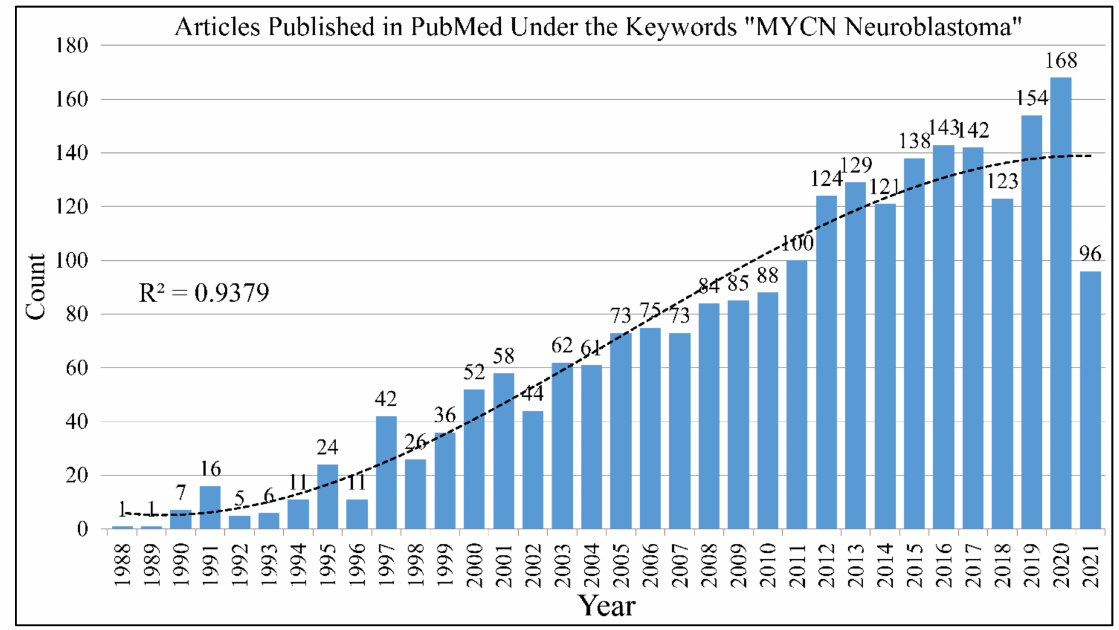
Figure 1. The literature concerning the role of MYCN in neuroblastoma. A total of 2166 citations come up in the PubMed database with the keywords “MYCN” and